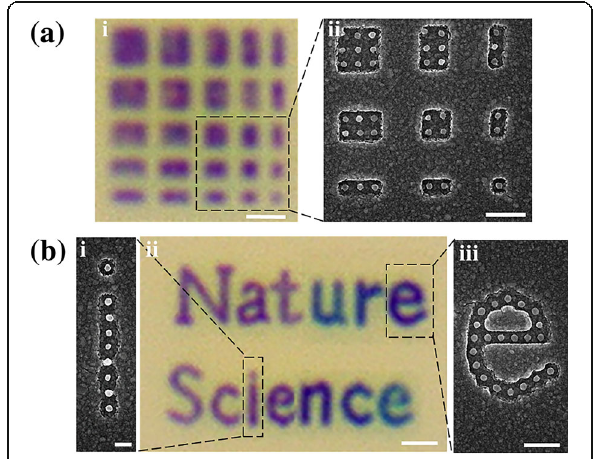
Fig. 5 a Color printing resolution test pattern. b Subwavelength color printing of “ Nature ” and “ Science ” with the size of 6 μ m × 9 μ m. The scale bars are a -i 1 μ m, a -ii 500nm, b -i 200nm, b -ii 1 μ m, and b -iii